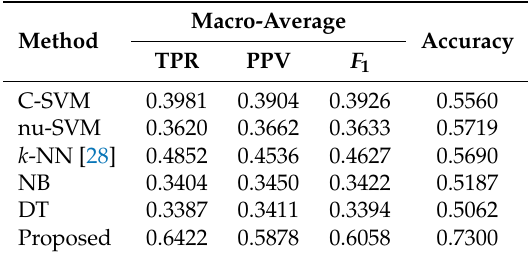
Table 14. Leave-one-person-out cross-validation performance comparisons between the proposed ensemble model and five benchmark